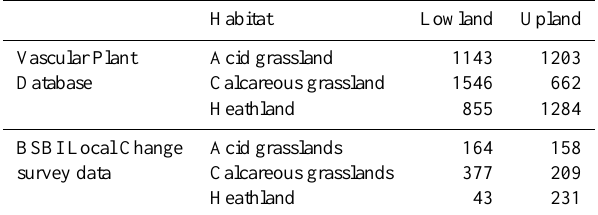
Table 1. The number of sampling units (hectads or tetrads) across Great Britain containing each of the three studied habitats from each of the two surveys. Habitat Lowland